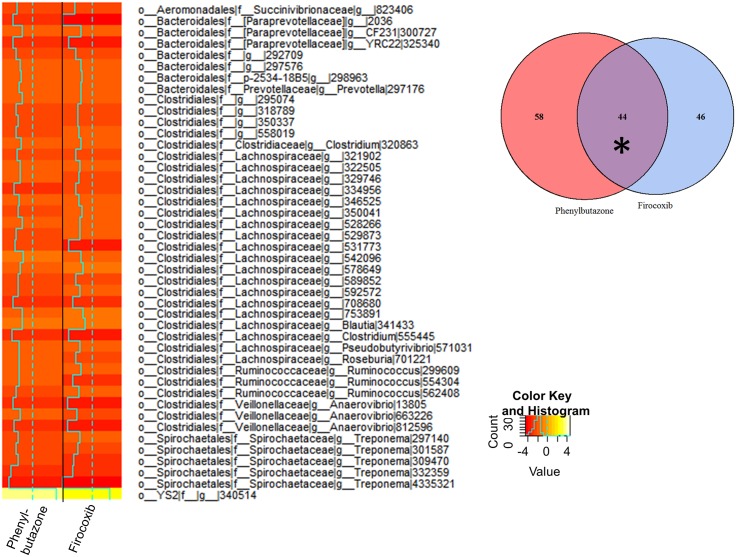
NSAID administration resulted in similar fecal microbiota changes irrespective of COX selectivity. This change was characterized primarily by a reduction in the members of the phylum Firmicutes, mainly Lachnospiracea after 10 days of NSAID administration.Heatmap showing log2 fold change of concordant DE OTUs between both phenylbutazone (left column) and firocoxib (right column) treated horses between days 0 and 10. Dashed line in center of each heatmap column represents log2 fold change of 0 (i.e., no fold change), solid line represents mean log2 fold change specific to each OTU within each treatment group. Asterisk in Venn diagram (inset) visually depicts the source of the 44 OTUs represented in this heatmap.